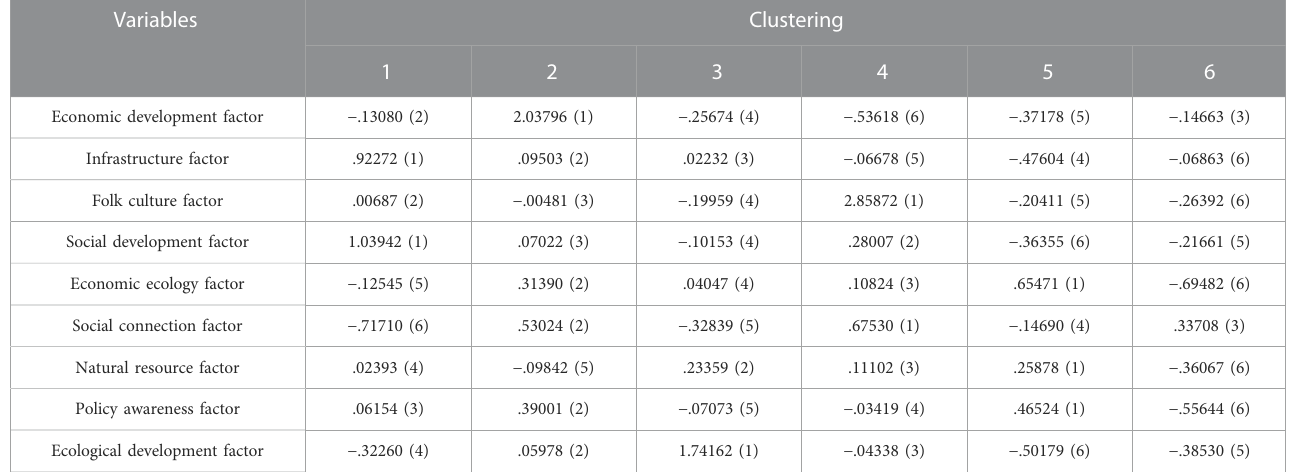
TABLE 4 Final clustering center table.